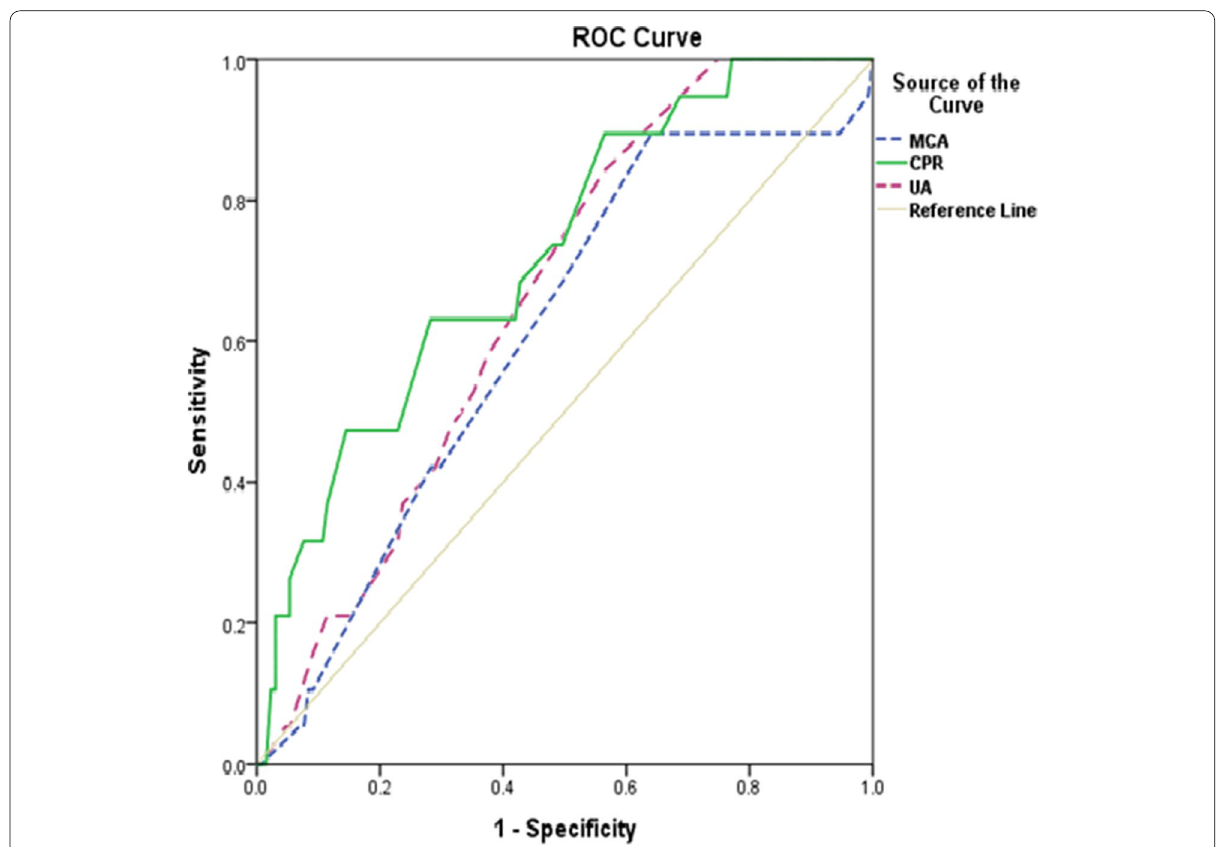
Fig. 3 Receiver–operating characteristic curves for prediction of NICU admission using cerebroplacental ratio, umbilical artery, and fetal middle cerebral artery pulsatility index